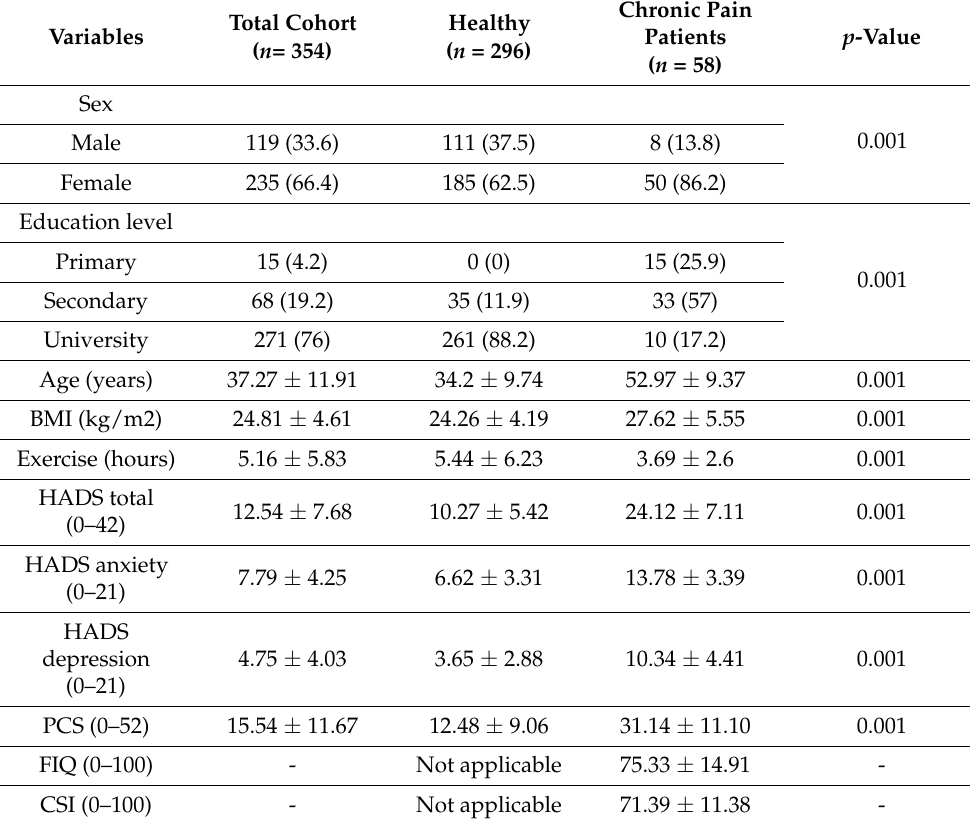
Table 1. Descriptive characteristics for the total cohort and the two populations